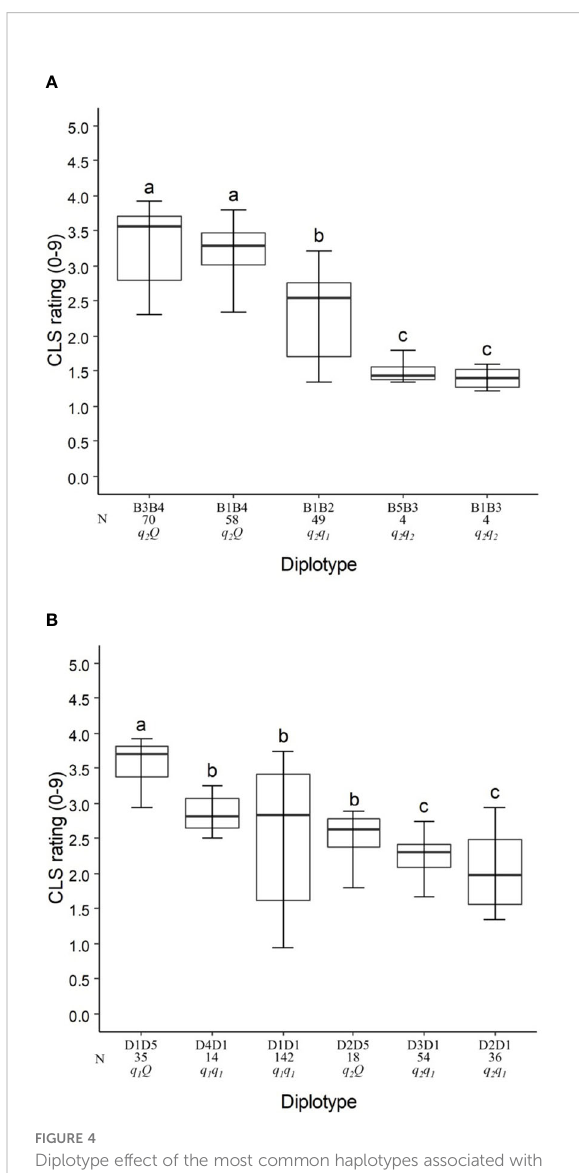
FIGURE 4 Diplotype effect of the most common haplotypes associated with cercospora leaf spot QTLs q CLS.TX2WSE-LG3.1 (A) and q CLS.TX2WSE-LG6.2 (B) in six diploid rose populations (TX2WSE). Means not connected by the same letter are signi fi cantly different ( P<0.05 ) within each linkage group. N = Diplotype sample